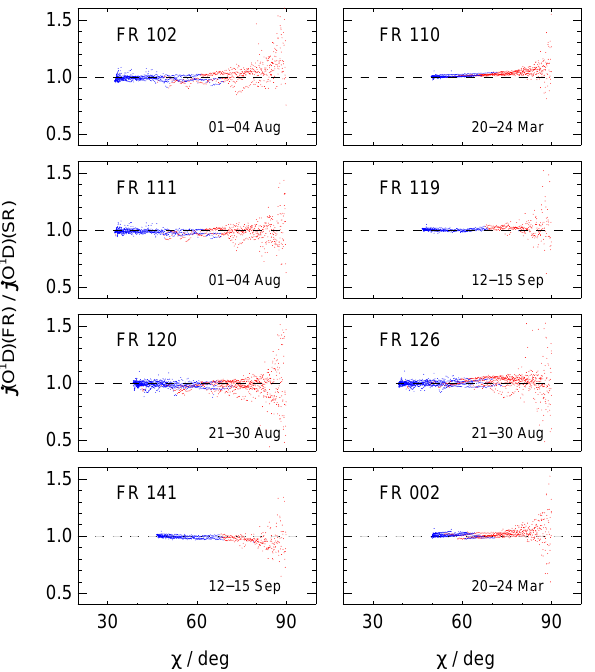
Figure 11. Ratios of photolysis frequencies of subsequent compar- isons as a function of solar zenith angles after the exchange of inter- ference filters. For direct comparison red data points indicate values below 2 . 8 × 10 − 6 s − 1 as in Fig. 10. Different 3–8-day measurement periods are indicated explaining different ranges of solar zenith an- gles and number of data